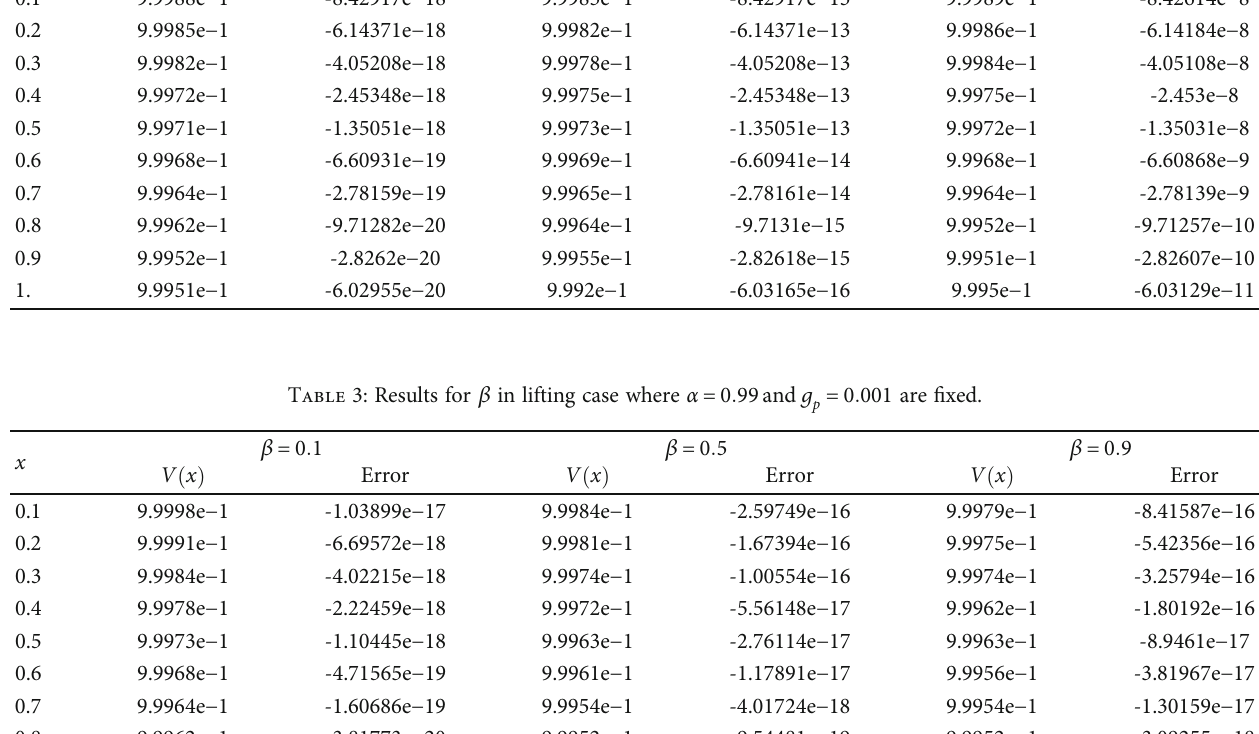
Table 2: Results for g in lifting case where α = 0 : 95and β = 0 : 1 are fi xed. p